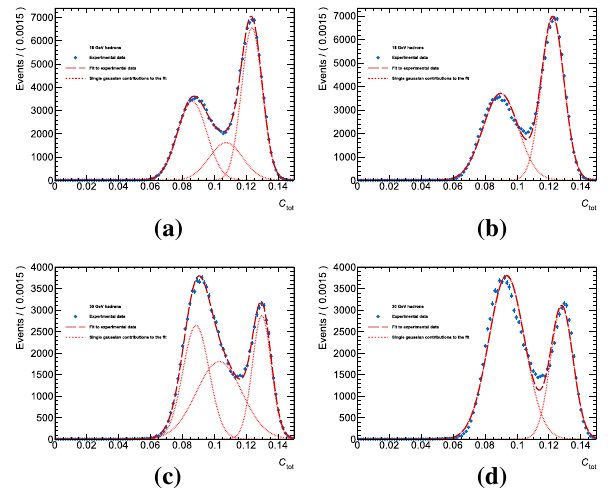
Fig. 12 The blue dotted histograms represent the C tot distributions of e /π sampleeventswith E beam equalto18GeV( a , b )and30GeV( c , d ), respectively. The events are limited to those with C long ≥ 0.6. Multi- modal three- and two-Gaussian fit functions (red dashed curves) are superimposed on the histograms ( a , c and b , d ), respectively. The func- tions parameters were obtained using the maximum likelihood method. Red dotted curves show the individual Gaussian function contributions to these fits. In each histogram, the function with the largest value of the mean μ describes the electron contamination. As discussed in Sect. 3.2.2, Three-Gaussian fits were used to determine the numbers of electrons contaminating the samples. Two-Gaussian fits were used to